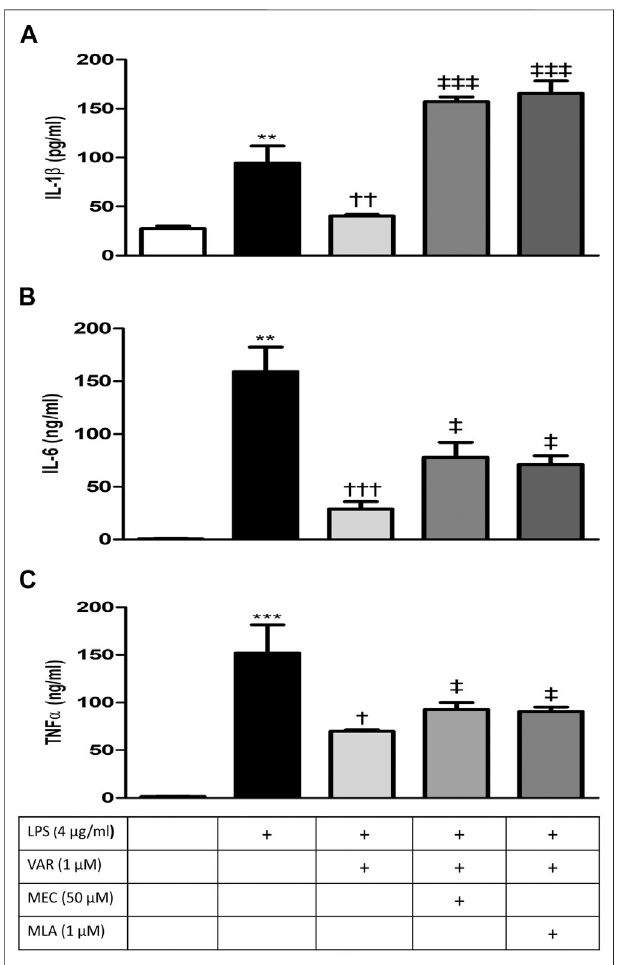
FIGURE 4 | Effects of varenicline on LPS-induced IL-1 β , IL-6, and TNF α elevationsinthepresenceorabsenceofnAChRantagonists.Shownare4 μ g/ ml LPS-elevated IL-1 β (A) ; IL-6 (B) , and TNF α (C) levels in the absence or presence of varenicline (VAR, 1 μ M), mecamylamine (MEC, 50 μ M) and methyllycaconitine (MLA, 1 μ M). Data are shown as mean ± S.E.M. (** p < 0.01;*** p < 0.001vs.thecontrolgroup, † p < 0.05; †† p < 0.01, ††† p < 0.001vs. LPSgroup; ‡ p < 0.05, ‡‡‡ p < 0.001vs.LPS+VAR, n (cid:1) 5 – 7,One-wayANOVA with post hoc Tukey – Kramer multiple comparisons test or Student ’ s